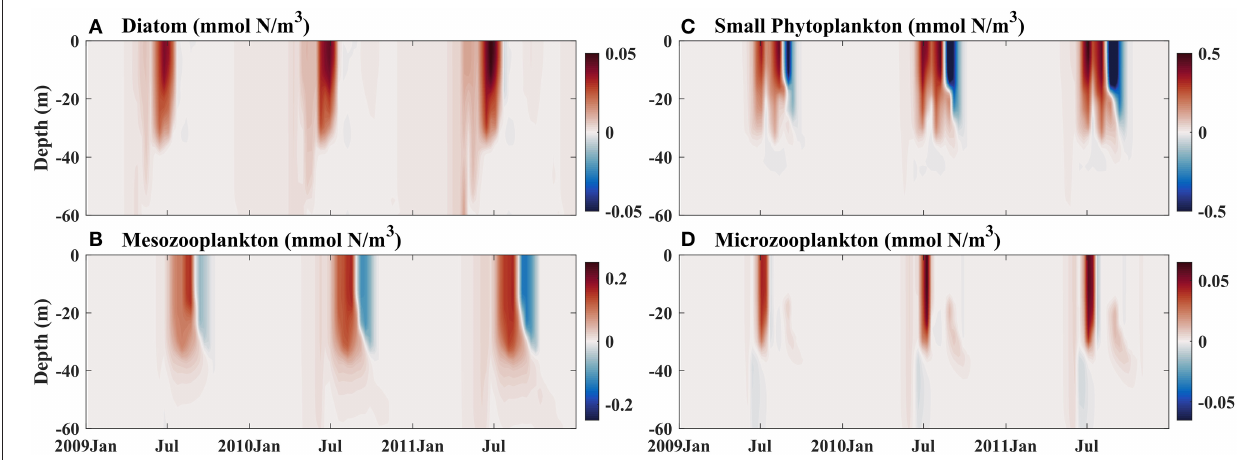
FIGURE 11 | Modeled vertical distributions of differences in (A) diatoms (mmol N/m 3 ), (B) small phytoplankton (mmol N/m 3 ), (C) mesozooplankton (mmol N/m 3 ), and (D) microzooplankton (mmol N/m 3 ) between the control run and sensitivity experiment Exp 1, which was forced with two times the dissolved Fe dust deposition after 2009, at Stn.